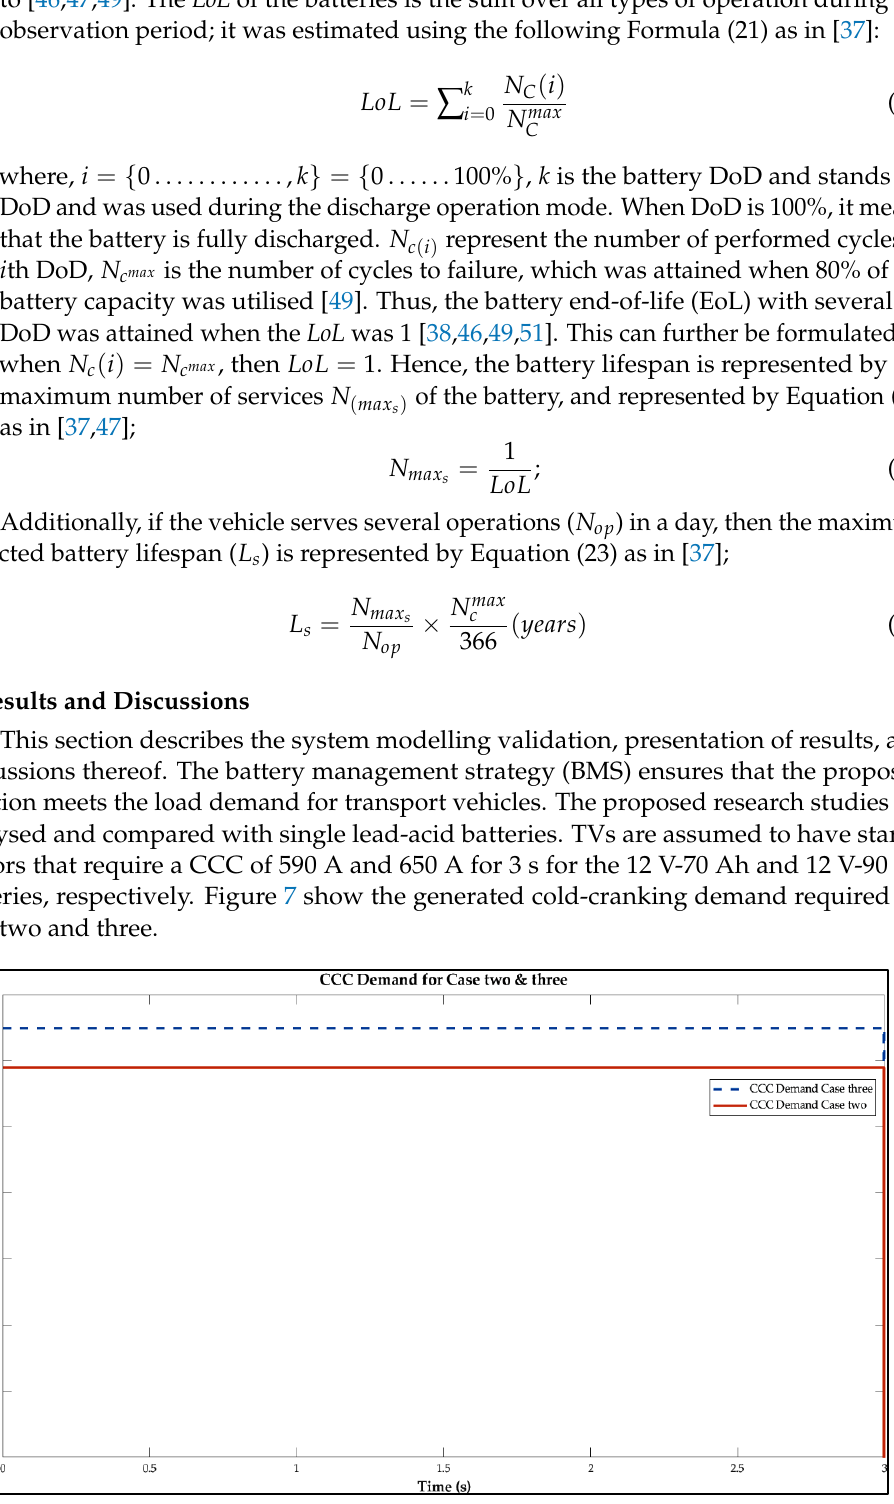
Figure 7. Generated cold cranking current or ampere demand required to crank the engine.